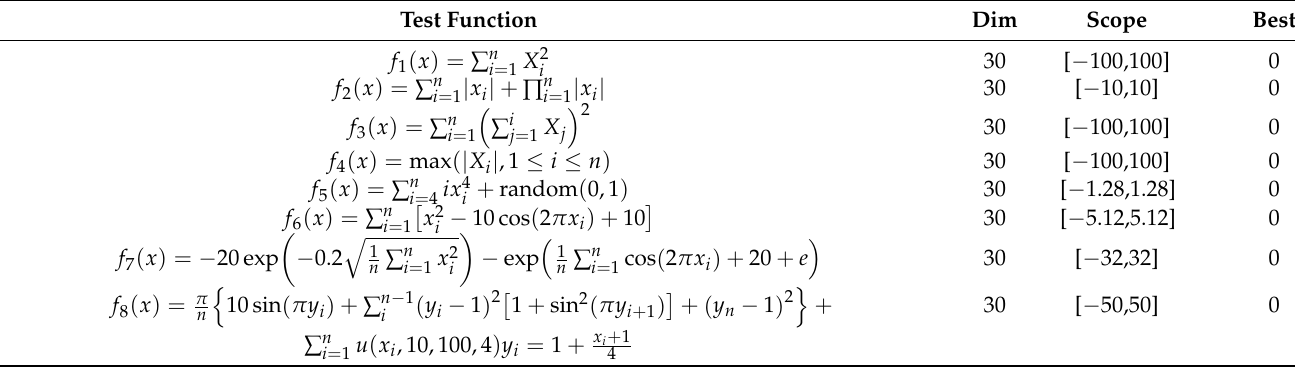
Table 2. Benchmark test function